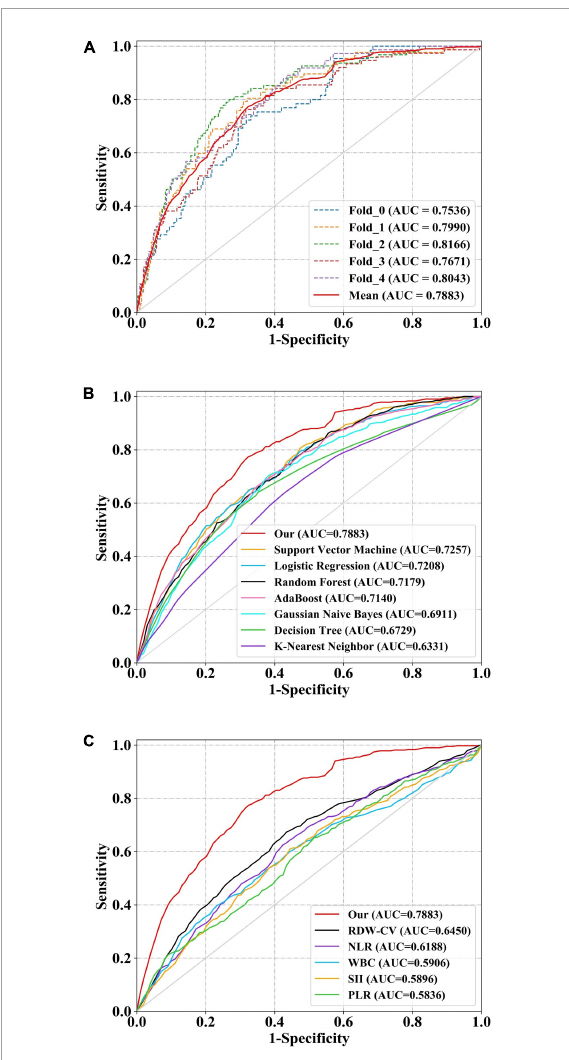
FIGURE3 Receiver operator characteristic (ROC) curves of models and indices for predicting in-hospital mortality. The solid red line indicates the mean ROC curve of our neural network model. (A) The solid red line indicates the average result of the 5-fold cross-validation. The other five dotted lines represent the result of each fold. (B) Our model had a significantly higher mean area under the curve (AUC) of 0.788 (95% CI, 0.736–0.838) than other models [including logistic regression (LR), k-nearest neighbor (KNN), support vector machine (SVM), Gaussian naive Bayes (GNB), adaptive boosting (AdaBoost), decision tree (DT), and random forest (RF)] ( P < 0.05). (C) The AUC of our model also outperformed that of other indices [includingwhite blood cell count (WBC), neutrophil-to-lymphocyte ratio (NLR), platelet to lymphocyte ratio (PLR), systemic immune-inflammation index (SII), and red blood cell distribution width-coefficient of variation (RDW-CV)] ( P < 0.05). ROC, receiver operator characteristic; AUC, area under the curve; CI, confidence interval; LR, logistic regression; KNN, k-nearest neighbor; DT, decision tree; SVM, support vector machine; RF, and random forest; AdaBoost, adaptive boosting; GNB, Gaussian naive Bayes; WBC, white blood cell count; NLR, neutrophil-to-lymphocyte ratio; PLR, platelet to lymphocyte ratio; SII, systemic immune-inflammation index; RDW-CV, red blood cell distribution width-coefficient of